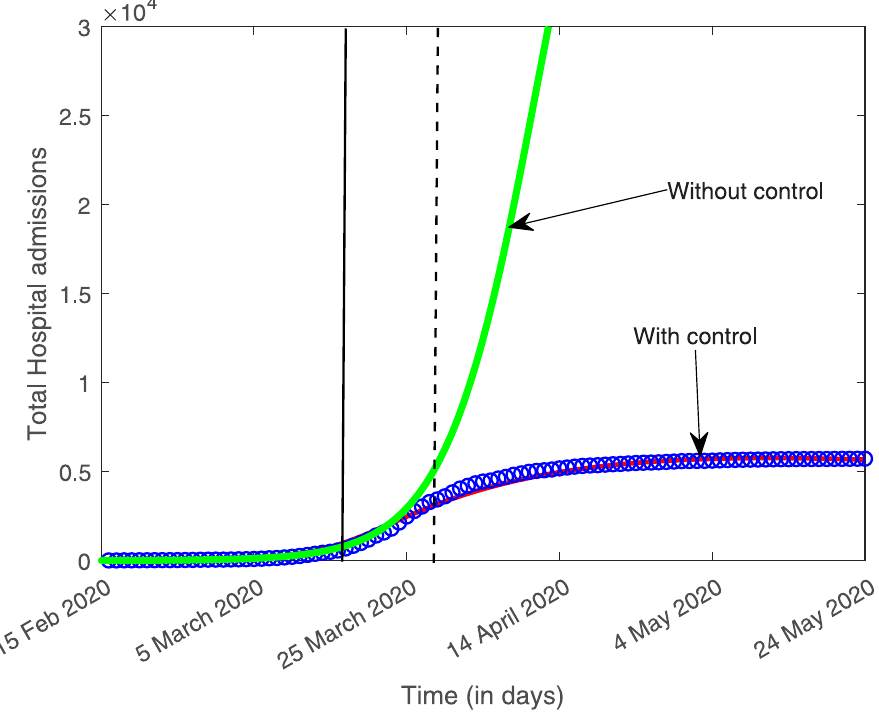
Fig 12. The following parameter set: ϕ = 1.4, � = 0.25, δ 1 = 0.003, δ 2 = 0.04, η 1 = 0.035, η 2 = 0.03, α 1 = 0.02, α 2 = 0.01, α 3 = 0.05, α 4 = 0.03 and a = 0.02, the deterministic dynamics for the overall hospitalizations ( H 1 + H 2 ) is shown with and without control. Cumulative data on overall hospitalizations are shown in blue. The simulation plotted as red line includes a control function ( β ( t ) = β 0 σ − ( x ( t )) + β 1 σ + ( x ( t )),with a standard sigmoid function s ð x Þ ¼ 1 , see [17]) which is able to describe the empirical data, while the green line shows the solution without any 1 þ e (cid:0) x control. The black line shows the last data point used in this study, March 25, 2020, ten days after the partial lockdown was implemented. By that date, the exponential growth of disease cases decelerates into a growth close to zero towards a linear phase. The full lockdown started on March 31, 2020 (black dashed line).